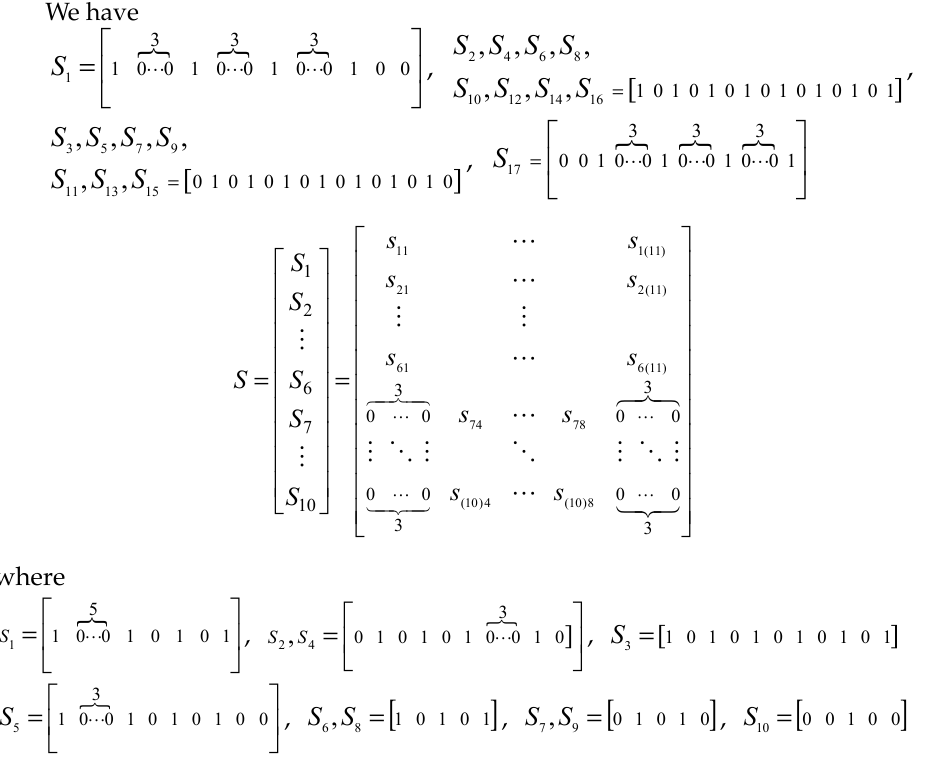
Figure 9. Three-track combination of 484 cross-break track and its fabric.